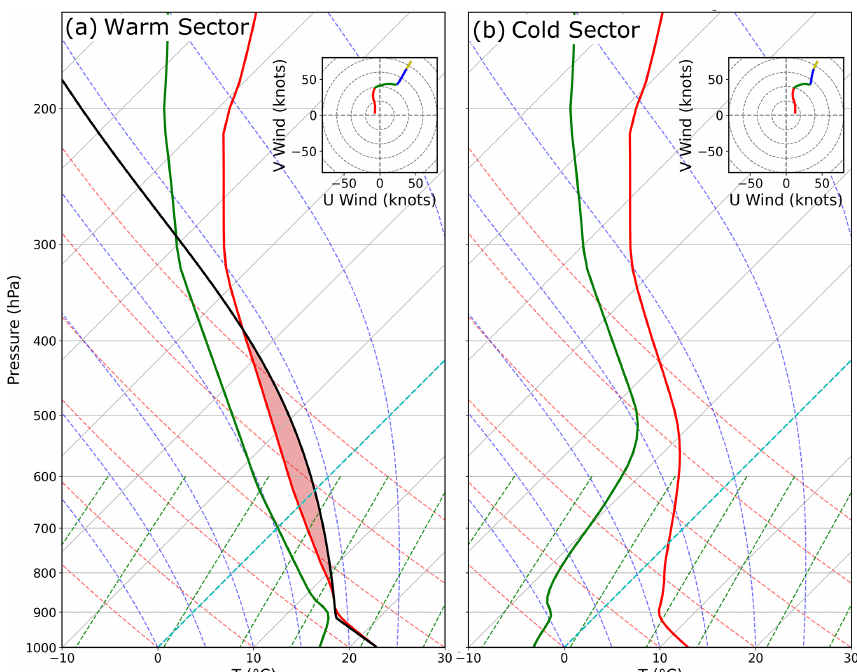
Figure 1. (a) The initial sounding for the nature run simulation. Vertical red lines and green lines correspond with T and T d . The vertical black line marks the temperature of an air parcel launched from the surface. The hodograph, which is plotted in the upper-right corner, is color coded by height above ground level (a.g.l.), and 0–1km is red, 1–3km is green, 3–5km is blue, and 5–10km is yellow. Both soundings also initialize the (a) warm sector and (b) cold sector simulations that create the forecast ensemble.